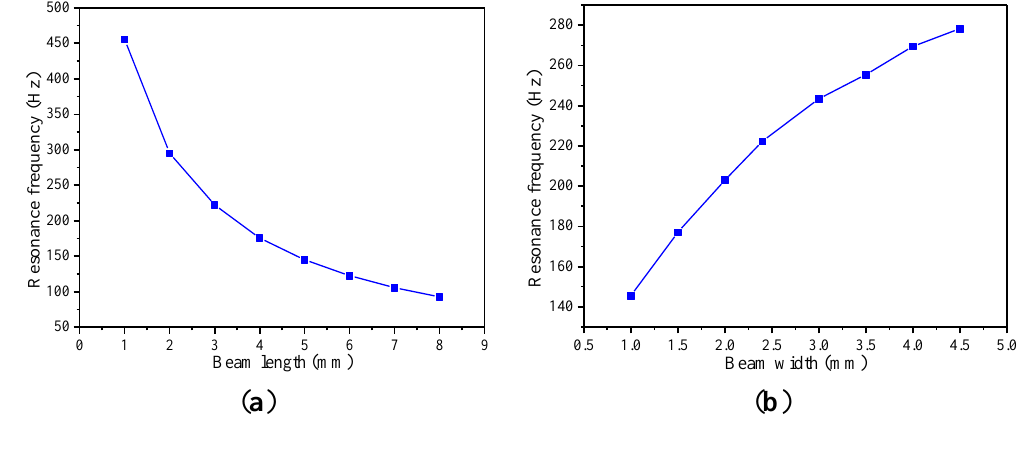
Figure 5. Resonance frequency versus dimensions of the beam. ( a ) Beam length. ( b ) Beam width. ( c ) Beam